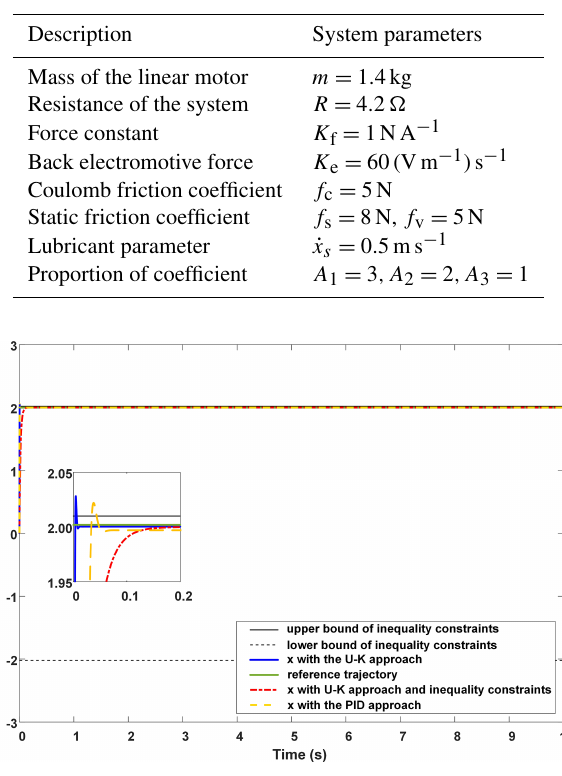
Figure 2. PMLM displacement under the step